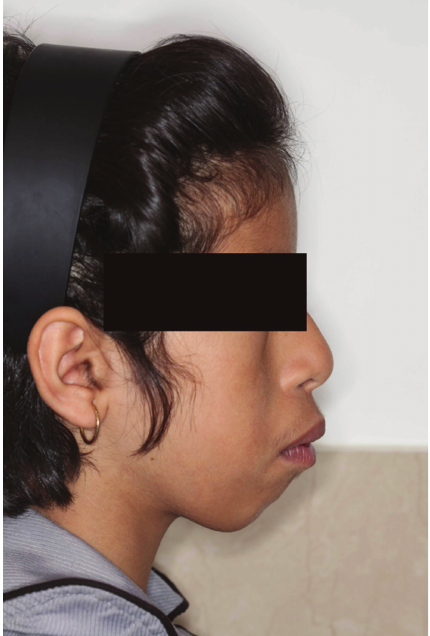
Figure 4: Profile view of the patient showing lip